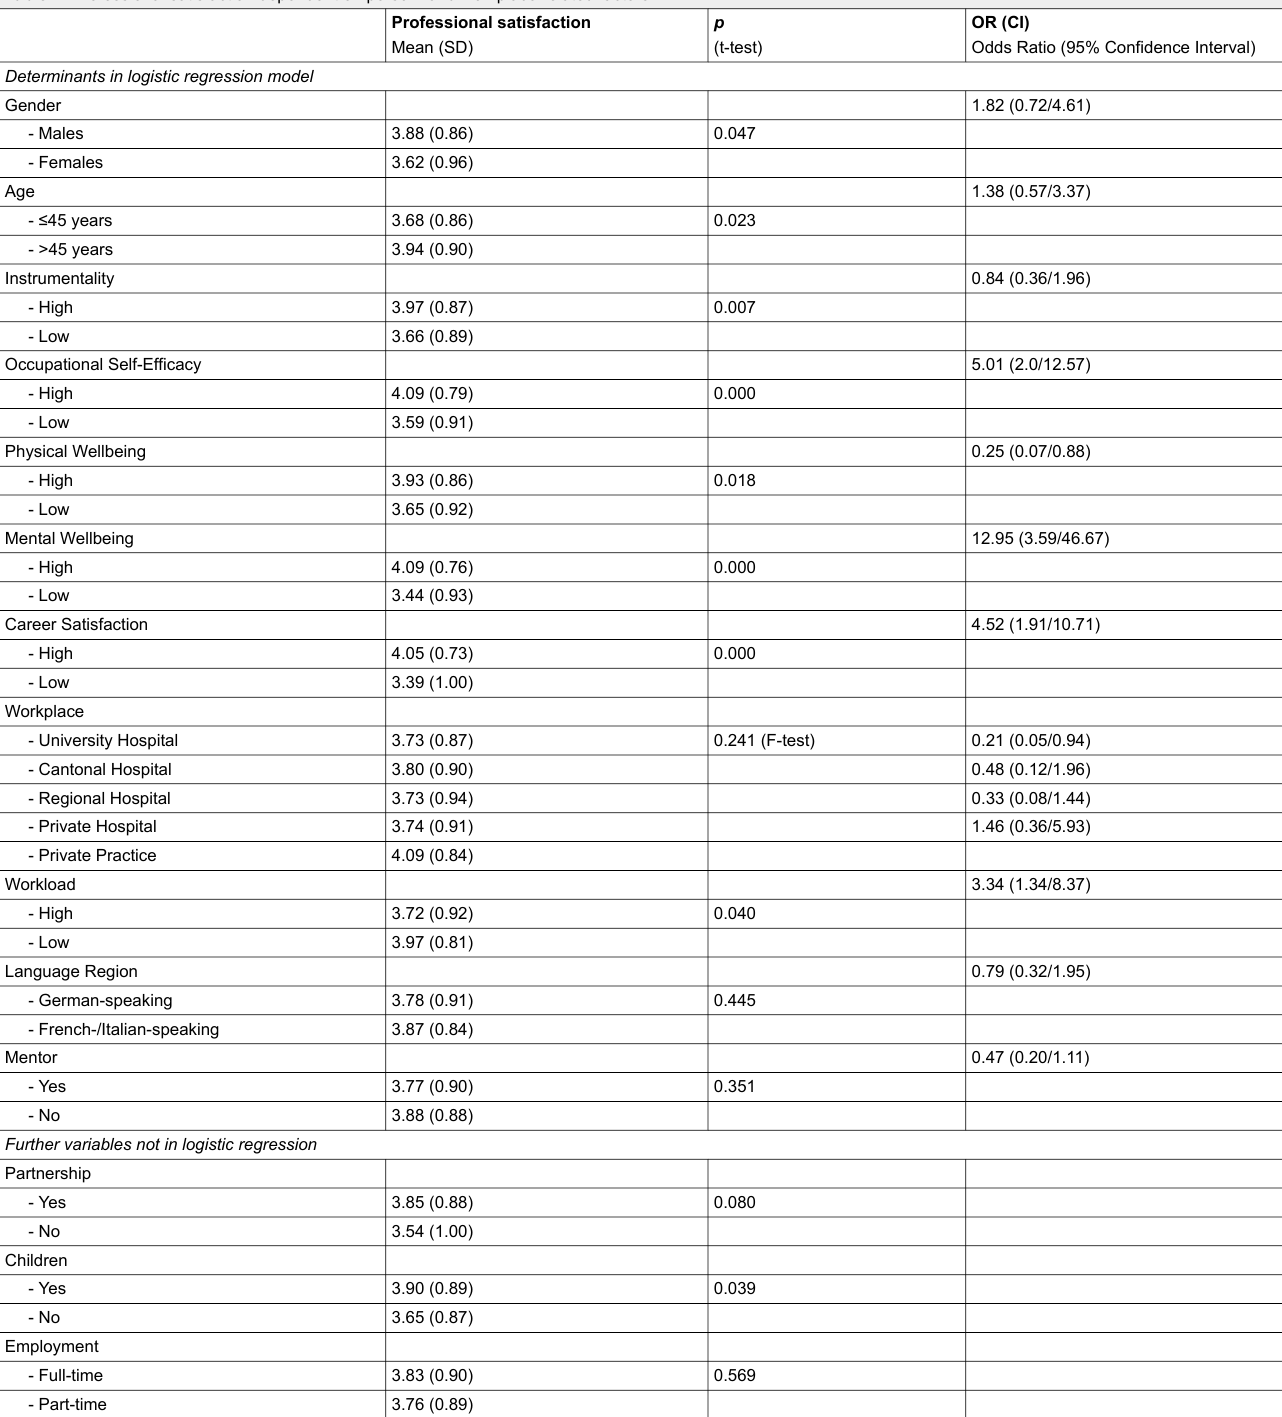
Table 1: Professional satisfaction dependent on person- and workplace-related factors.